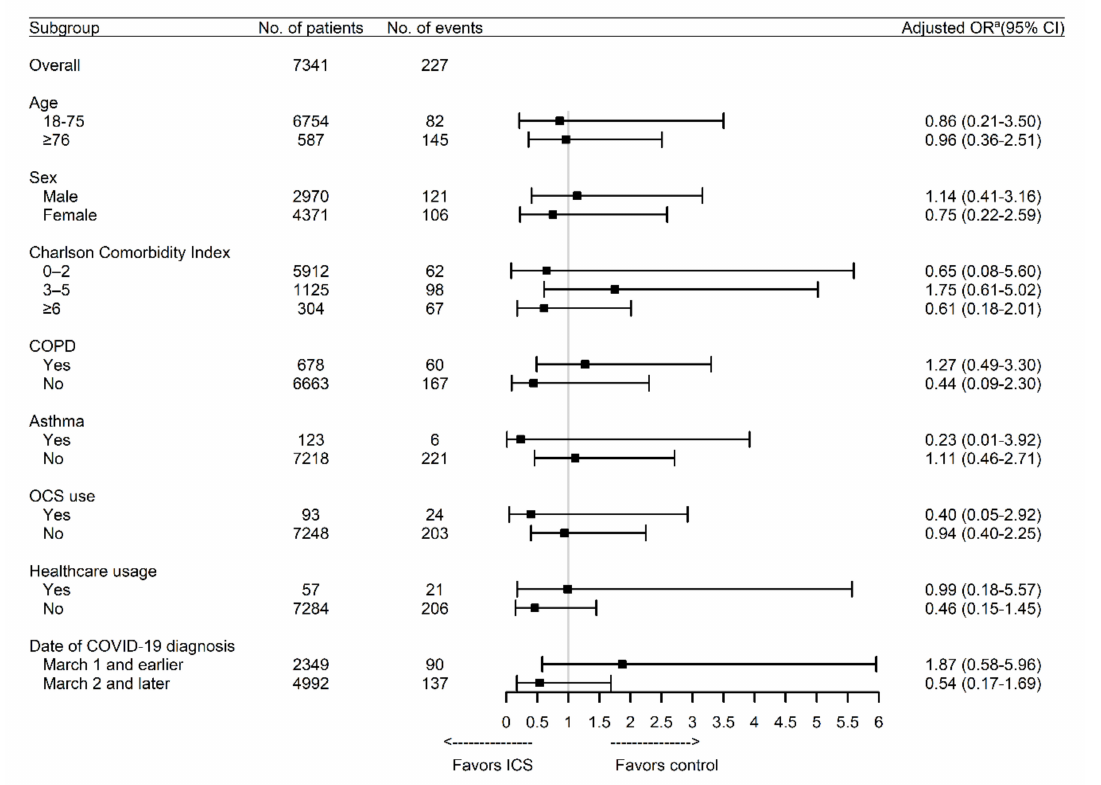
Figure 1. Association between the use of ICS and the risk of mortality according to subgroup. COPD: chronic obstructive pulmonary disease; COVID-19: coronavirus disease 2019; ICS: inhaled corticosteroids; OCS: oral corticosteroid. a Adjusted for age, sex, region, Charlson Comorbidity Index, and hospital